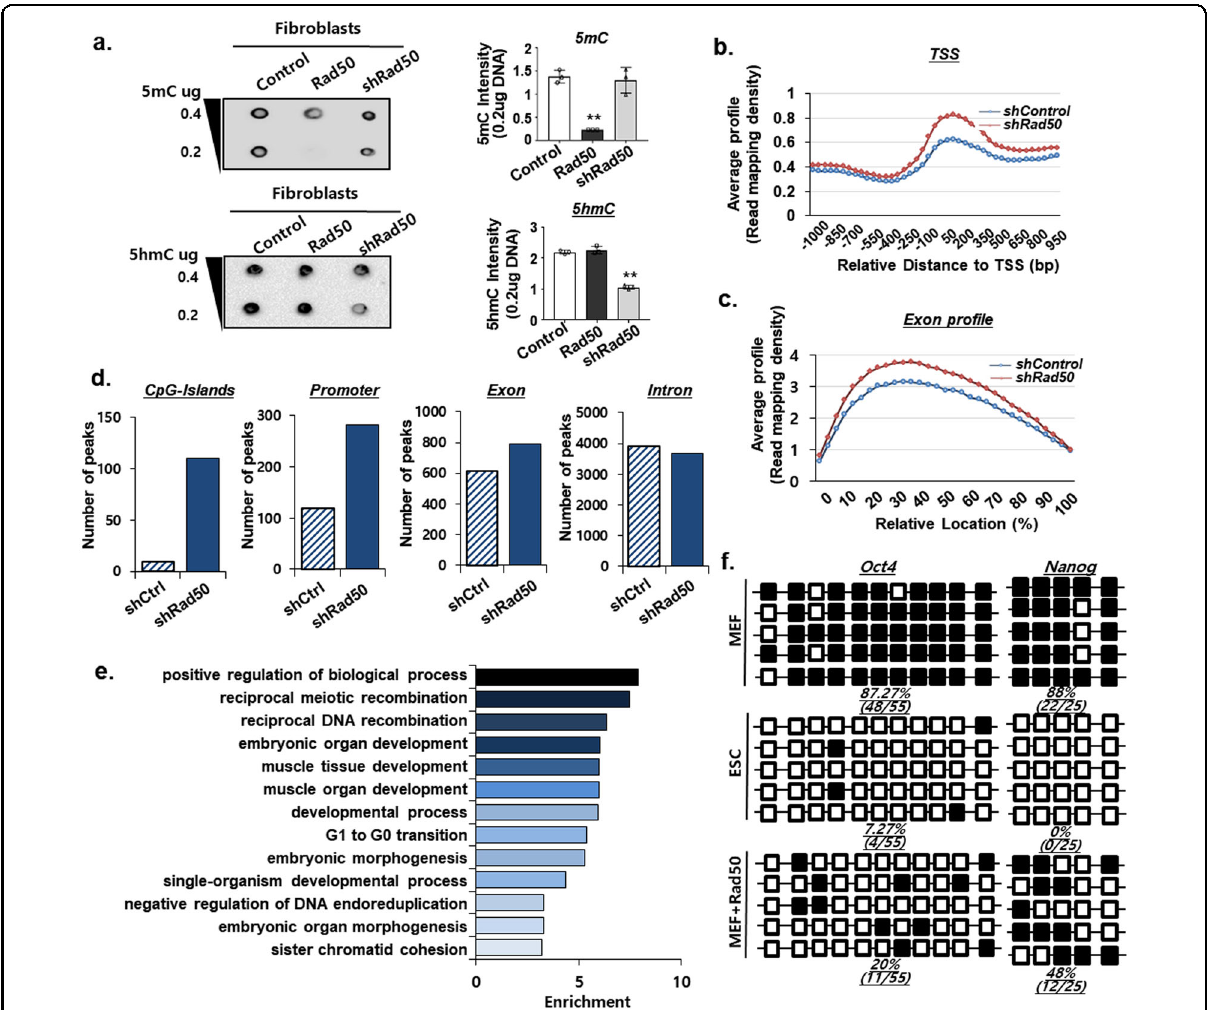
Fig. 2 Rad50 induction of global DNA demethylation. a Dot blot analysis of 5mC and 5hmC in diluted genomic DNA from MEFs with Rad50 overexpression or knockdown. The image is representative of ≥ 3 similar experiments. b Average pro fi le read mapping densities at the TSS determined by MBD-seq. c Average pro fi le read mapping densities at the exon determined by MBD-seq. d Annotation of the differentially hypermethylated CpG islands, promoter, exon, and intron region following Rad50 overexpression or knockdown. e Gene ontology (GO) enrichment analysis of the hypermethylated region following knockdown of Rad50. f Bisul fi te sequencing of the Oct4 and Nanog promoter regions in MEFs, mESCs, and Rad50-overexpressing